Question: What caption would you write for this figure?
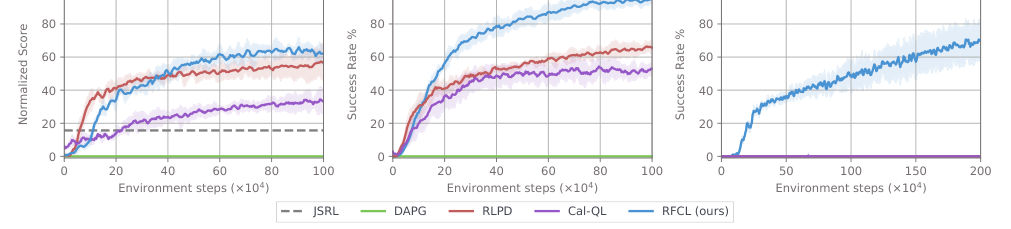
Answer: Mean success rate of algorithms for each environment suite across all tasks after 1M interaction steps with 5 demonstrations. Results are averaged within environment. Shaded areas represent 95% CIs over 5 seeds. The result show RFCL is significantly more performant and sample efficient compared to baselines. Note that RLPD and JSRL can normally achieve decent results but require many more demonstrations for harder tasks.